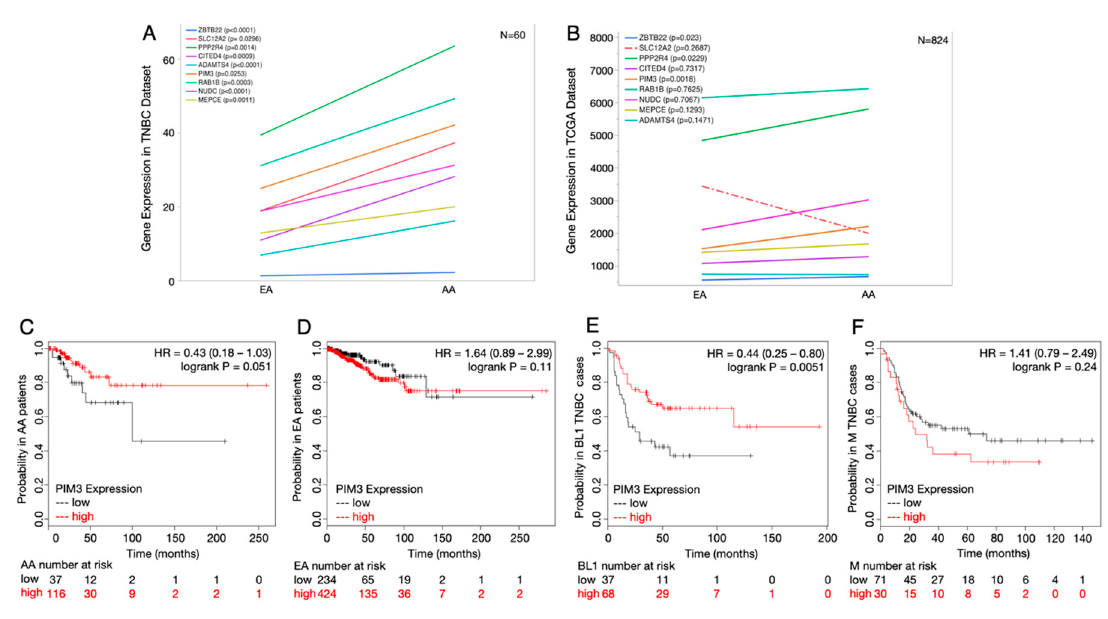
Figure 3. African ancestry-associated genes that are current drug targets in cancer treatments show different survival outcomes between SRR groups and breast cancer subtypes. ( A ) Gene expression levels between QGA differentially expressed genes identified as drug targets between SRR CAs and AAs in our TNBC dataset. ( B ) Gene expression levels between QGA differentially expressed genes in Figure 3A, but from the TCGA cohort. ( C ) Relapse-free survival curve of PIM3 for SRR AAs shows that higher expression of PIM3 is associated with higher probability of relapse-free survival ( p = 0.051). ( D ) Relapse-free survival curve for PIM3 for SRR CAs shows that higher expression of PIM3 is associated with lower probability of relapse-free survival ( p = 0.11). ( E ) Relapse-free survival curve of PIM3 for TNBC basal-like 1 tumors shows that higher expression of PIM3 is associated with higher probability of relapse-free survival ( p = 0.0051). ( F ) Relapse-free survival curve of PIM3 for TNBC mesenchymal tumors shows that higher expression of PIM3 is associated with lower probability of relapse-free survival ( p = 0.24).